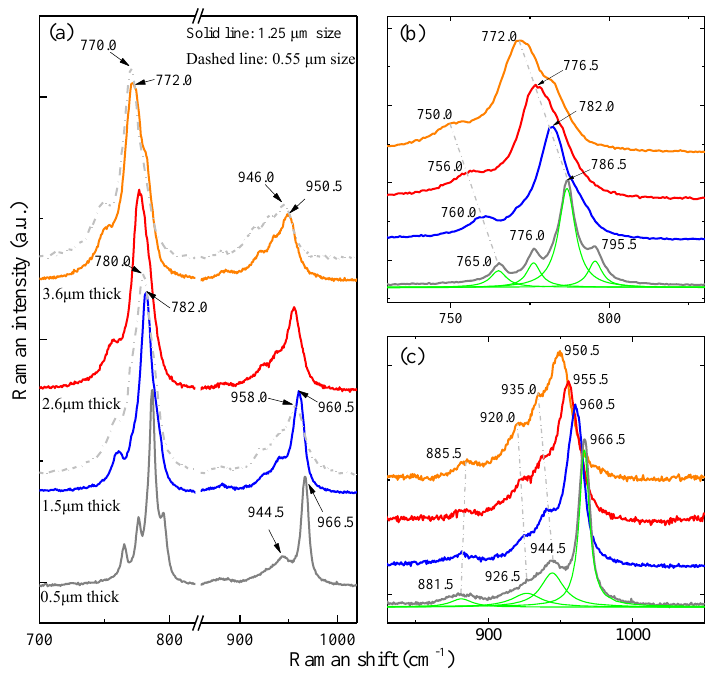
Figure 3. ( a ) Raman spectra of the 6H- SiC films with mean sizes of 1.25 μm (solid lines) and 0.55 μm (dashed lines) but different thicknesses; ( b , c ) Magnified spectral regions of the folded transverse optic (FTO) and folded longitudinal optic (FLO) bands in which the Lorenzian line-shape is adopted to fit the Raman spectra of the 0.5 μm thick films.